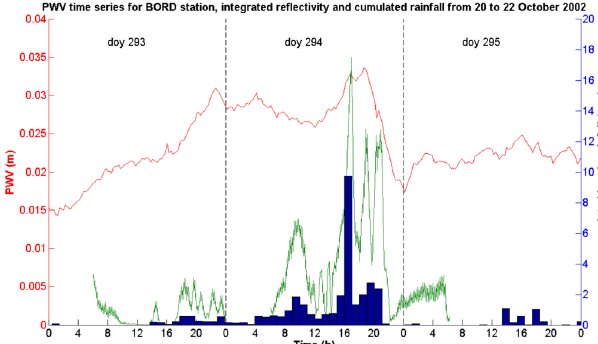
Fig. 14. PWV time series for 16 stations of the local network for the total measurement campaign in